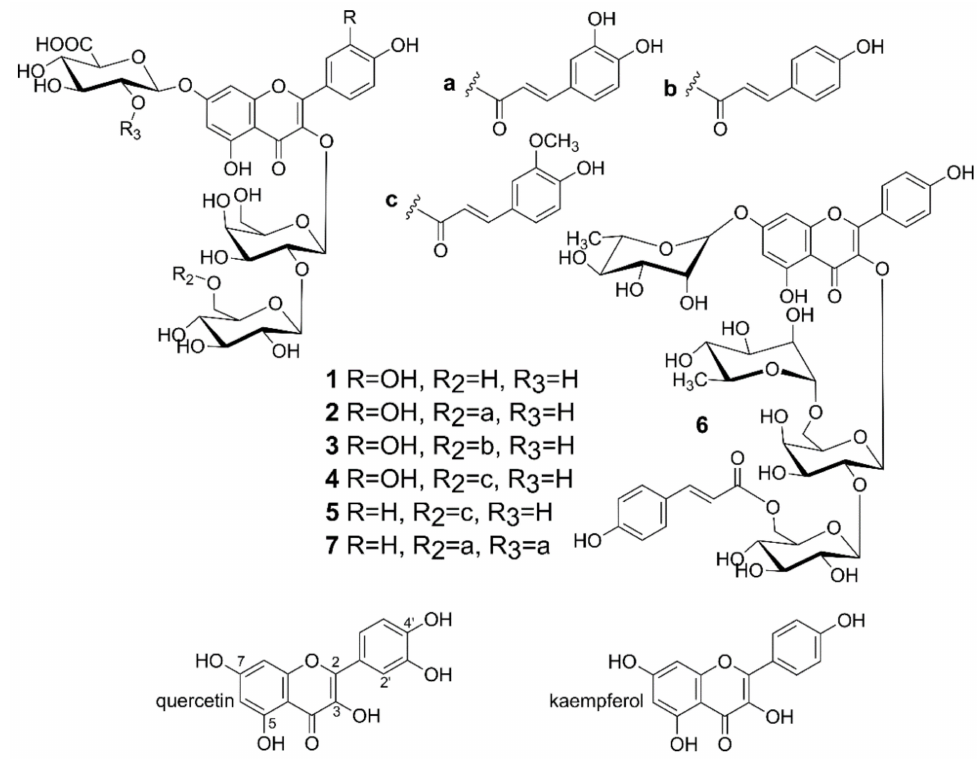
Figure 1. Structures of the investigated